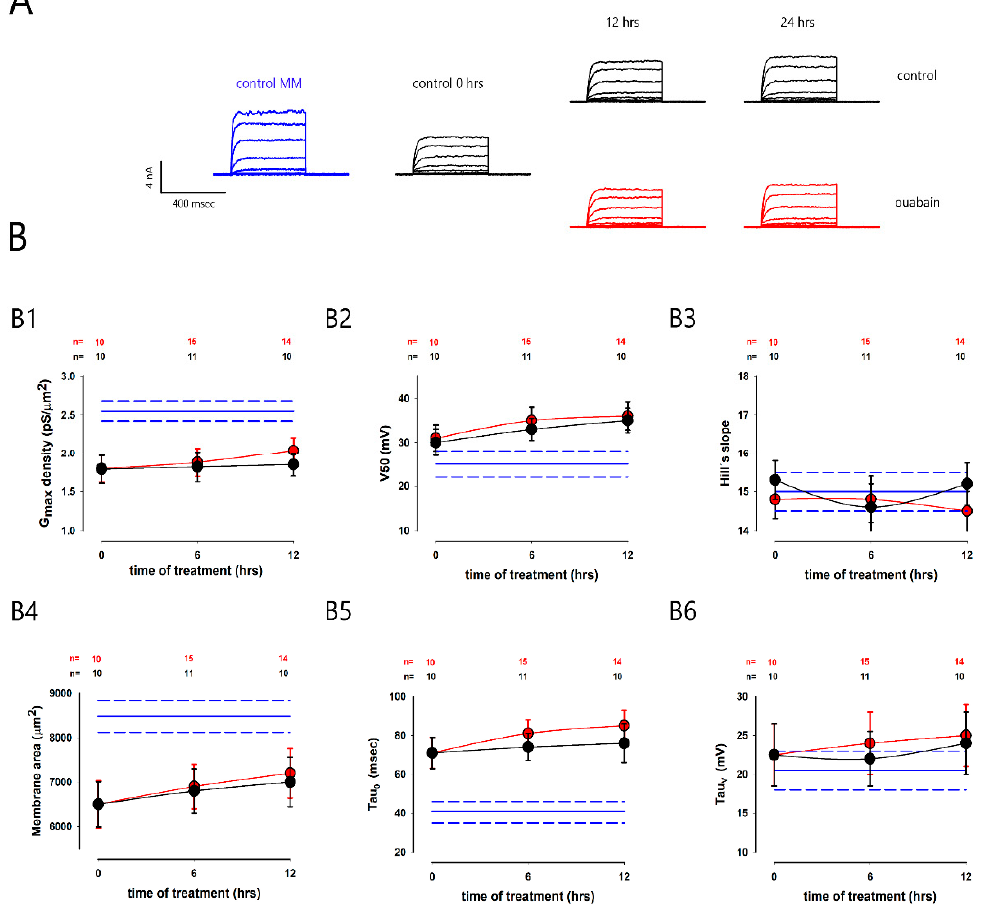
Figure 4. Effect of ouabain on subconfluent cells. ( A ) A representative example of series of currents obtained from individual cells under different conditions: the blue series was obtained from a cell in a mature monolayer, after three days of being seeded at confluence; the series marked as ‘control 0 h’ was recorded from a cell, two days after being seeded at subconfluence; and the other series shown were recorded from cells that were either untreated or treated with ouabain for 12 and 24 h. ( B ) Graphs ( B1 – B6 ) compare the mean values ( ± SE) of the: ( B1 ) maximum conductance density, ( B2 ) V 50 , ( B3 ) Hill’s slope, ( B4 ) membrane area ( B5 ) τ 0 and ( B6 ) τ v , both under control conditions ( black circles ) and treated with ouabain ( red circles ). In each graph, the horizontal blue lines indicate the corresponding values for mature monolayer (MM) cells. The asterisks show a statistically significant difference between the values represented by the circles and the corresponding values of cells in the mature monolayer (MM). The numbers at the top of each graph indicate the number of repetitions.